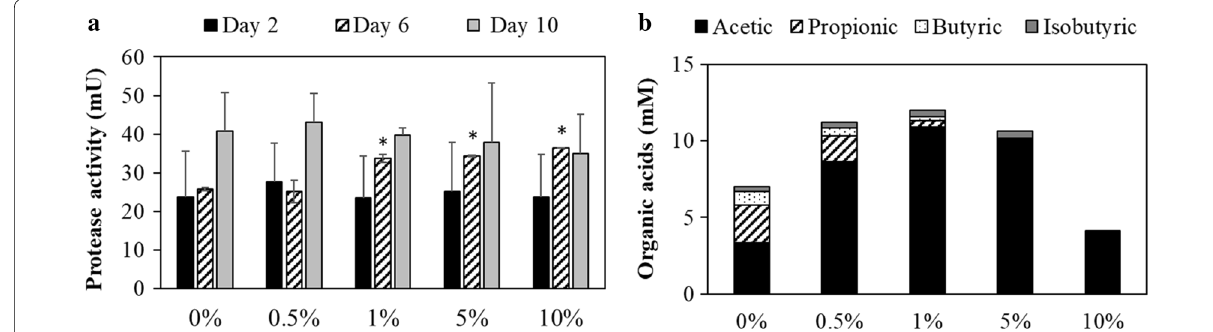
Fig. 3 Impact of Aso limonite to the hydrolysis and the acidogenesis stages of anaerobic digestion; a protease activity at day 2, 6, and 10 to evaluate the hydrolytic activity of WSS and b organic acids at day 6 to evaluate the acidogenesis process. Aso limonite was mixed with WSS to be the following concentrations (0%, 0.5%, 1%, 5%, and 10% w/v). Error bars indicate standard errors (n difference by the addition of Aso limonite